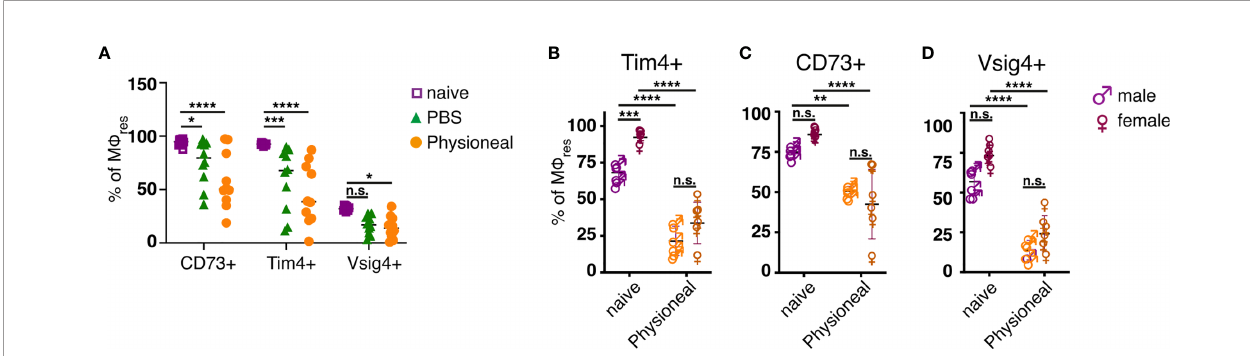
FIGURE 4 | Repeated injection of sterile saline induces similar alterations to dialysis fl uid. (A) Female C57BL/6 mice were injected 5 times a week for a total of nine injections with Physioneal (circles), sterile PBS (triangles) or left untreated (squares). 24 h after the last injection whole PEC were isolated and analysed by fl ow cytometry for expression of M F res associated cell-surface markers. Data pooled from two independent experiments. (B – D) Male ( ♂ ) and female ( ♀ ) C57BL/6 mice were injected 5 times a week for a total of nine injections with PD fl uid (orange symbols) or left untreated (purple symbols). 24 h after the last injection whole PEC were isolated and analysed as described for (A) . Datapoints depict individual animals and lines indicate mean and SD. Data from a single experiment. Data analysed using 2-way ANOVA followed by Tukey ’ s multiple comparison test after transformation. n.s., not signi fi cant; *p < 0.05; **p < 0.01; ***P<0.001; ****p <